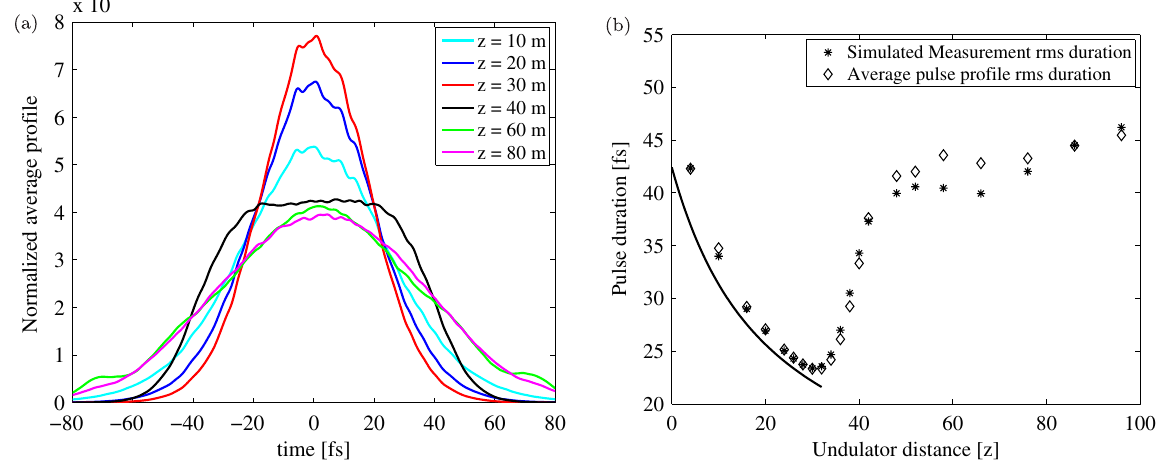
FIG. 4. Results for the Gaussian electron bunch profile with 18 (cid:7) m rms length. (a) Normalized average x-ray profile. A low pass filter has been used to remove the residual spiky structure from the 500 shots average. (b) Pulse duration vs undulator distance. Calculated average profile rms duration (diamonds), simulated measurement rms duration